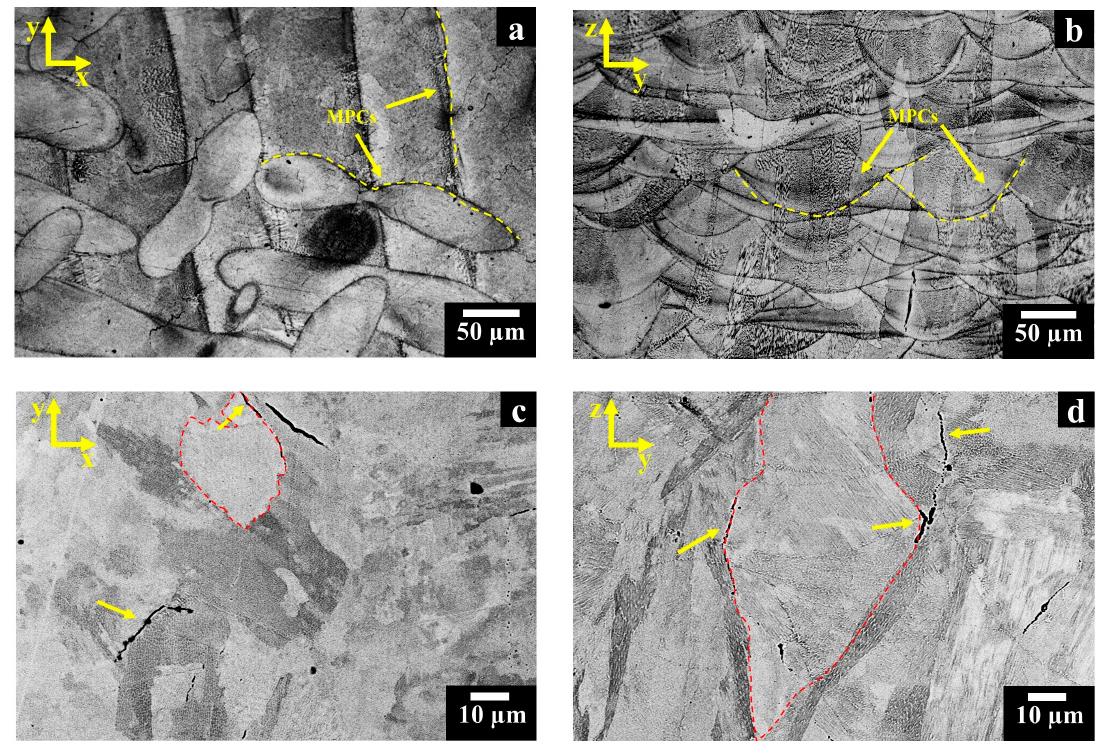
Figure 4. ( a , b ) OM images of as-built Hastelloy X (HX) sample showing melt pool contours (MPCs) along the x-y and z-y planes; ( c , d ) SEM images in BSE mode of as-built HX sample with equiaxed (x-y plane) and columnar (z-y plane) grains marked by red dash lines, exhibiting cracks crossing the grain boundaries, as indicated by yellow arrows.